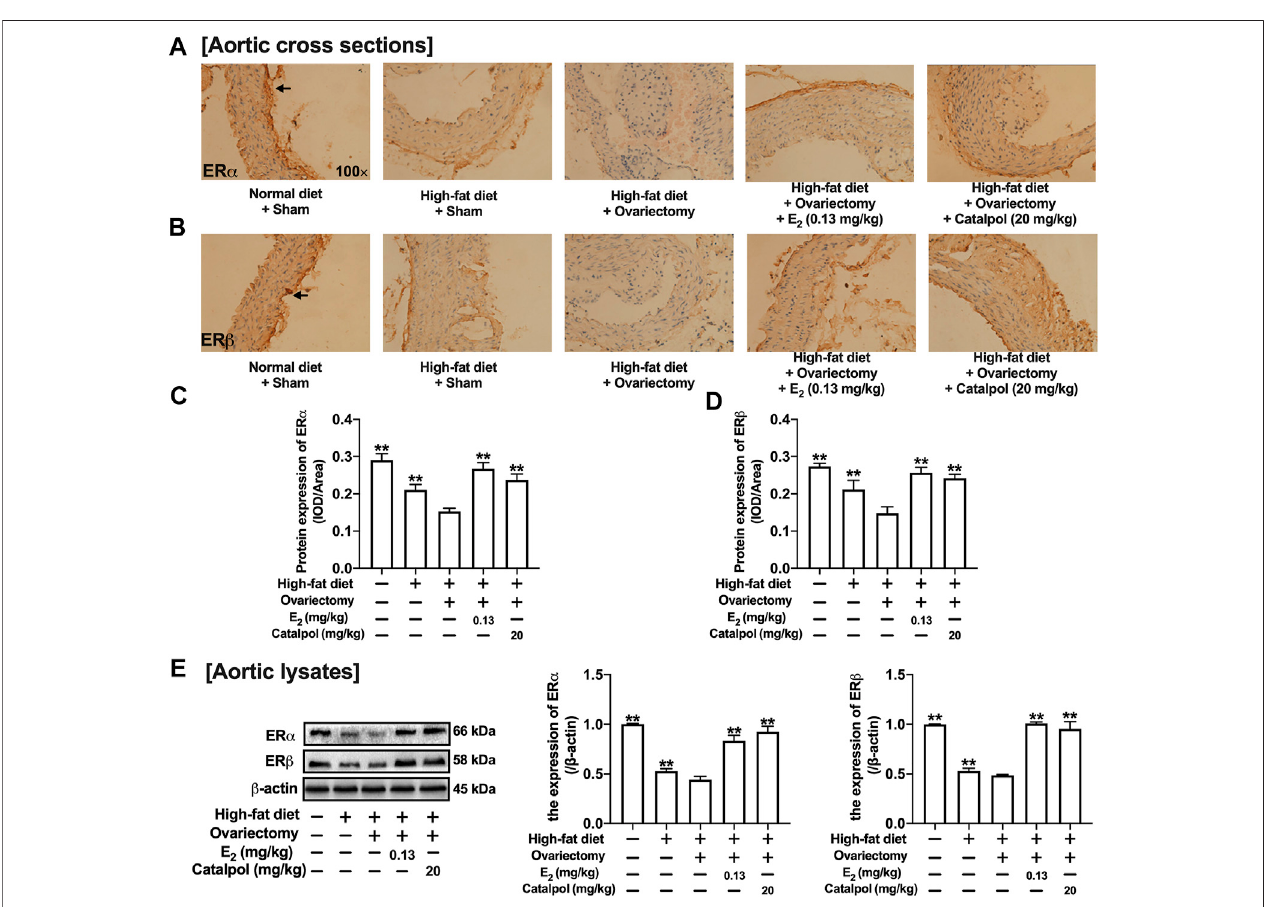
FIGURE 9 | Catalpol promoted the expressions of ERs in HFD-Ovx-treated ApoE − /- mice. Effects of catalpol on the expressions of ER α (A) and ER β (B) in cross- sectionsoftheaortas. (C) EffectsofcatalpolontheexpressionsofER α andER β werealsodetectedbywesternblot( n (cid:2) 3).Dataareexpressedasmean ± SD.* p < 0.05, ** p < 0.01 vs. Ovx